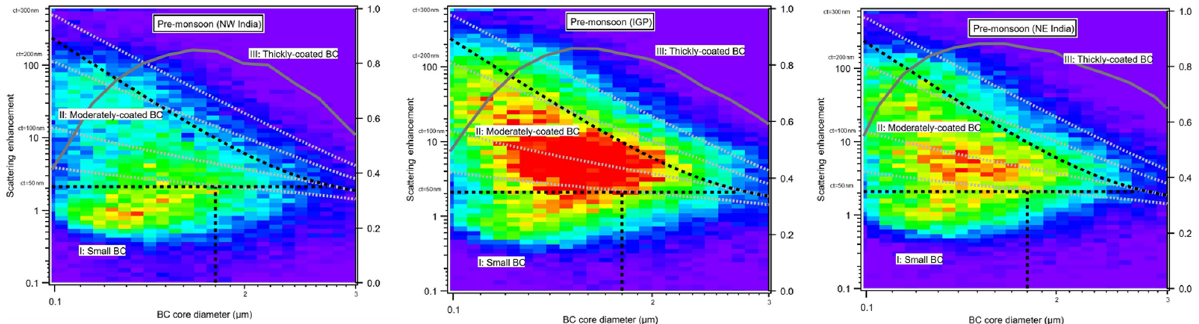
Figure 6. BC optical properties the pre-monsoon (PM) season with the location sampled highlighted in the plot title. The plots present the scattering enhancement ( E s ) as a function of BC core diameter ( D c ). The image plot is a two-dimensional histogram for the detected particles. The dashed grey contours show the absolute coating thickness (nm, (D p − D c )/ 2). The solid grey line, with corresponding scale on right axis, shows the number fraction of BC particles that were successfully determined according to their scattering signal at each D c size.